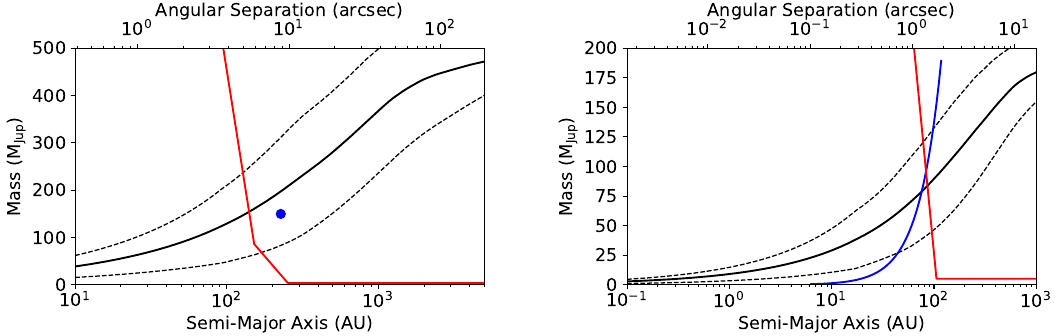
Figure 1. Mass vs. semi-major axes of companions compatible with the observed ∆ µ for HD 67458 ( left panel ) and HD 80913 ( right panel ), calculated using the COPAINS (Code for Orbital Characterization of Astrometrically Inferred New Systems; see [47] for details) and assuming a uniform distribution for the eccentricity. The red curve shows Gaia’s sensitivity limits [27,50]. The blue dot in the left panel shows the position of the companion to HD 67458 retrieved in Gaia DR2. The blue solid line in the right panel shows the position of the companions compatible with the RV trend observed by [38] for HD